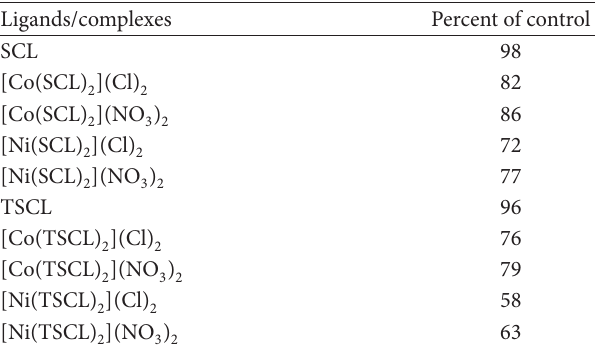
T 3: In�uence of ligands and metal complexes on the initiation of lipid